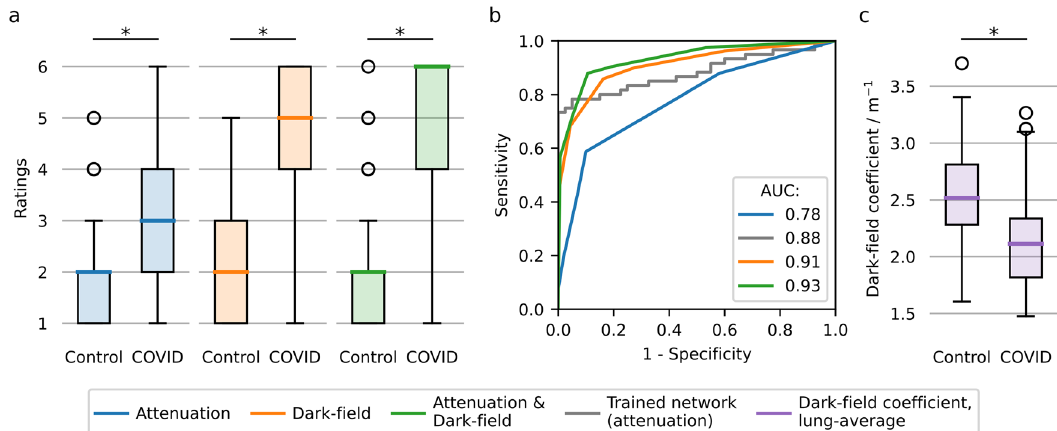
Fig. 5 Results of clinical evaluation and statistical analysis. a Box plot of reader scores for both healthy subjects ( n = 40) and infected patients ( n = 60) in dark- fi eld-based, attenuation-based, and dark- fi eld & attenuation-based readings. b Receiver operator characteristic (ROC) analysis for the respective modalities for the differentiation between infected patients ( n = 60) and healthy subjects ( n = 40). Additionally, an AI algorithm (convolutional neural network) for COVID-19-pneumonia detection was applied for attenuation image evaluation. Area under the curve (AUC) values were 0.78 (attenuation), 0.88 (trained network on attenuation), 0.91 (dark- fi eld), and 0.93 (dark- fi eld & attenuation), respectively. c Objective, quantitative image analysis, showing the average dark- fi eld coef fi cient (integrated over the whole lung area and evaluated after segmentation) for the lungs of healthy subjects ( n = 40) and infected patients ( n = 52) in a box plot. Signi fi cant differences are indicated by asterisks: * , p < 0.05. Abbreviations: AUC , area under the curve. Boxes in the box plots extend from the lower to upper quartile values of the data, with a line at the median. The whiskers extend to 1.5 times the interquartile range (Q3 – Q1). Small circles represent fl ier points past the end of the whiskers. Underlying data can be found in Supplementary Data